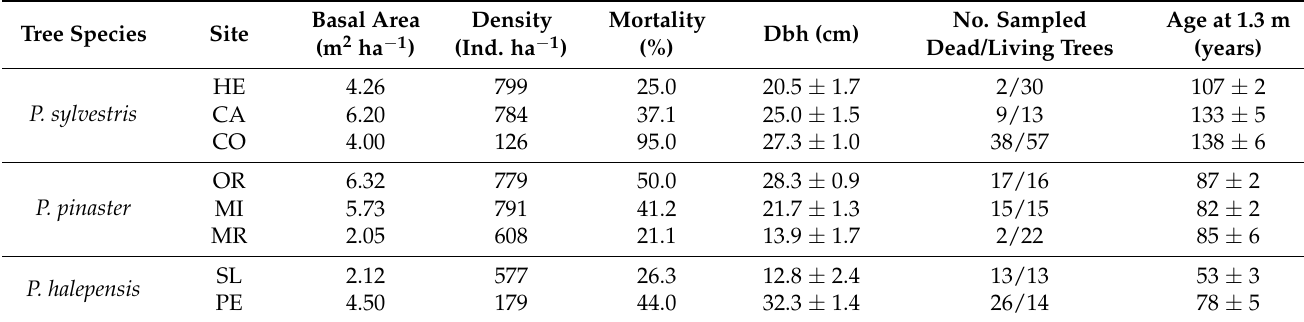
Table 2. Structural variables measured or calculated for the three pine species. Basal area and density refer to both living and dead trees. Dbh is the diameter at breast